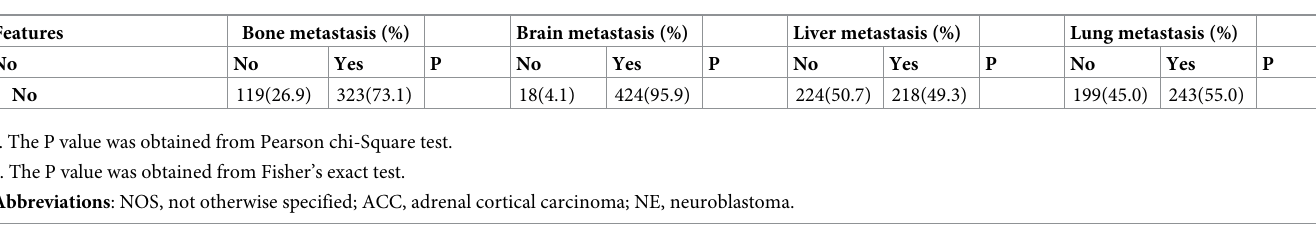
the worst prognostic metastasis both in OS and CSS. The same as the univariate analysis, pri- mary site was an independent prognostic factor for adrenal metastatic cancer patients both in OS and CSS (P < 0.05). In the analysis of the primary site, the primary site in the cortex had a worse prognosis than that in the medulla in both OS and CSS (P < 0.05). With respect to the surgery, patients underwent the surgery showed the better prognosis for OS and CSS (all P < 0.001) (Table 5).